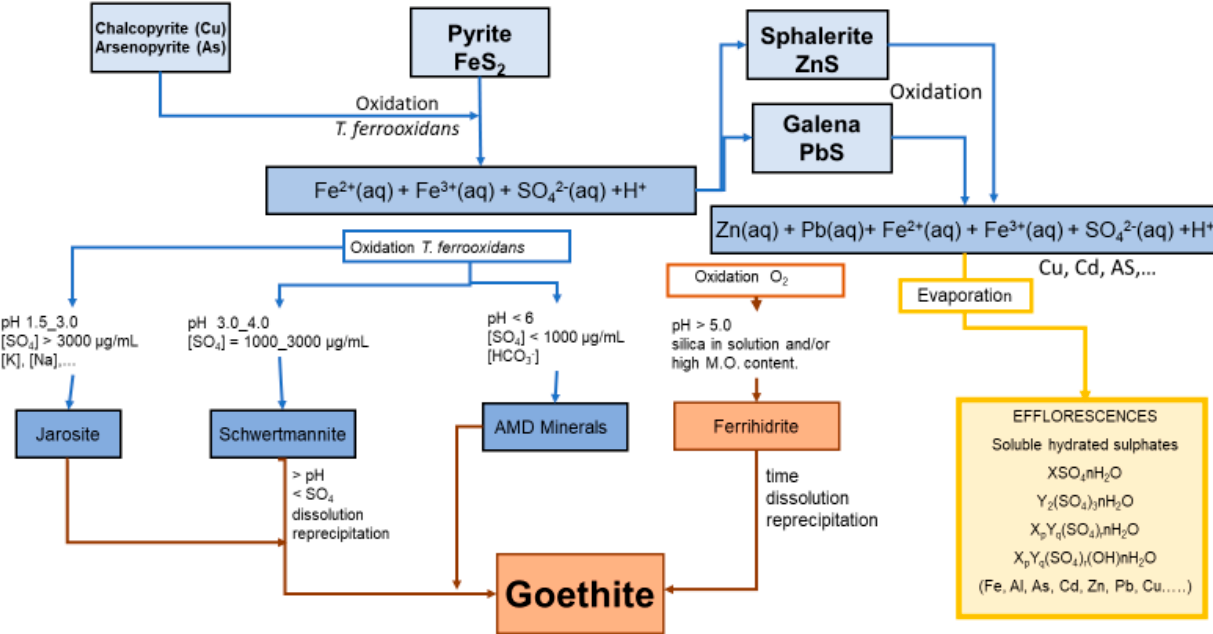
Figure 7. Biogeochemical model of supergene alteration of polymetallic mining (PSG). Table 4. Average concentrations of PTEs (mg/L, except As in μ g/L) in superficial water samples [28].